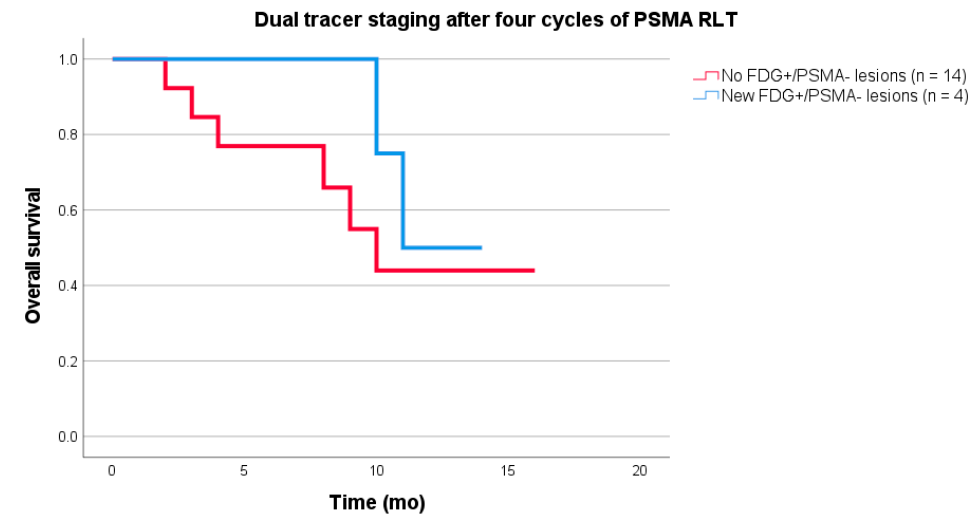
Figure 4. Kaplan–Meier curves of overall survival (OS). No significant difference for OS was found between the four patients with FDG+/PSMA − findings on dual tracer PET/CT (median OS not reached at the end of the follow-up period) after four cycles of PSMA radioligand therapy (RLT) and the 14 patients without FDG+/PSMA − lesions (median OS 10 (95% CI 7.2–12.8) months; p = 0.442).